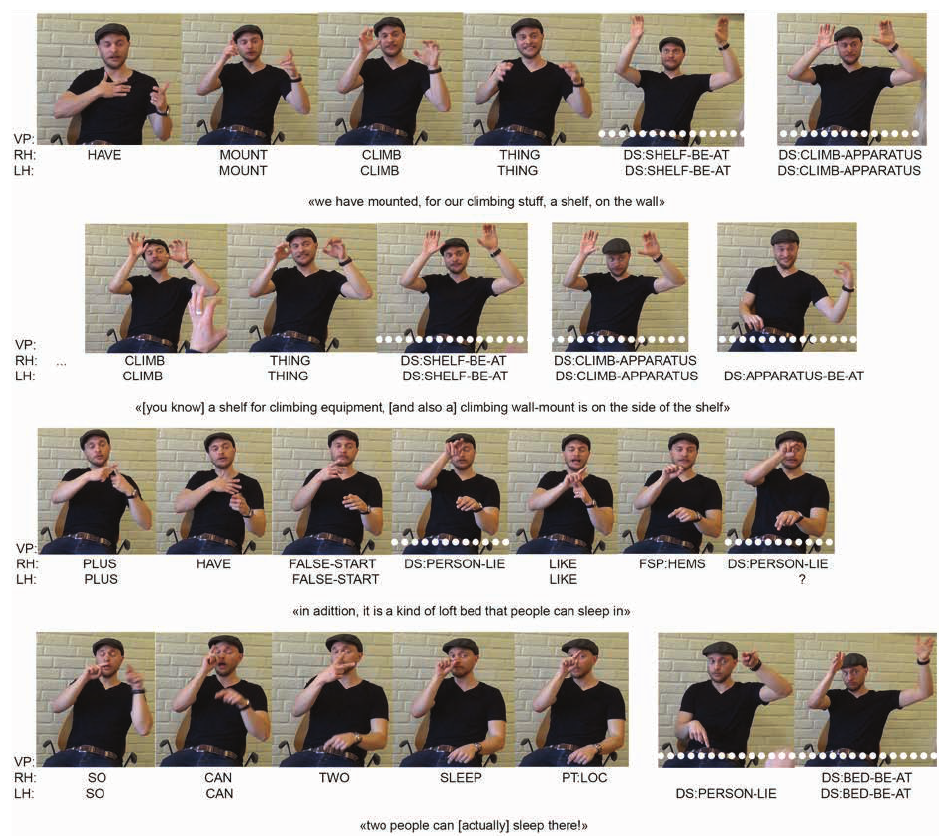
Figure 6: A signer depicting from a static vantage point within a conceptualized scene (DPNTS_O_PN.eaf,